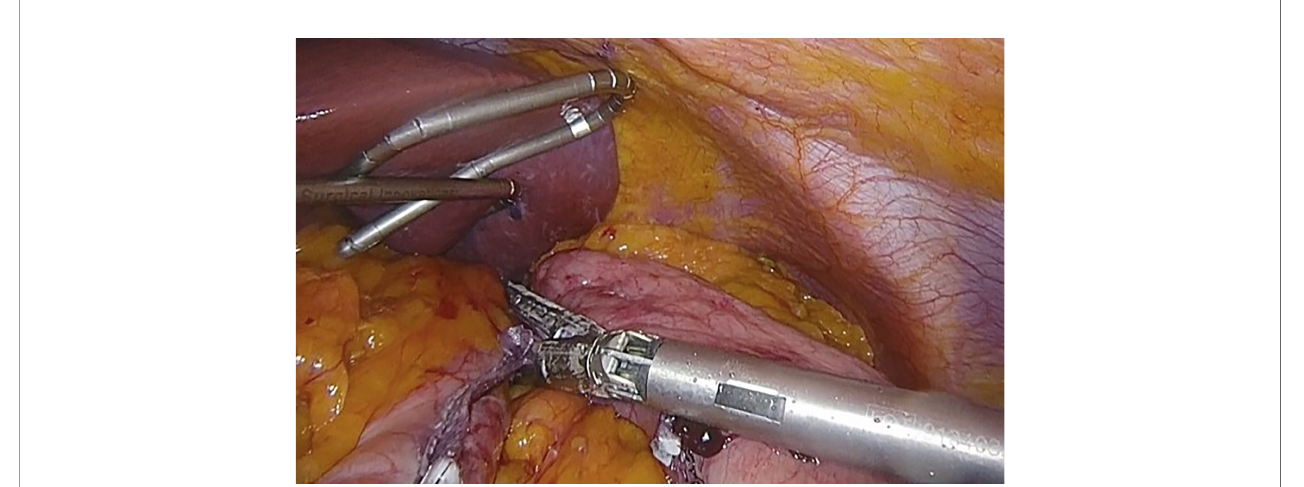
FIGURE 5 | Stapling and sectioning of the gastric curvature using the mechanical endostapler. Taken from the General Surgery and Digestive System Service, Hospital Royo